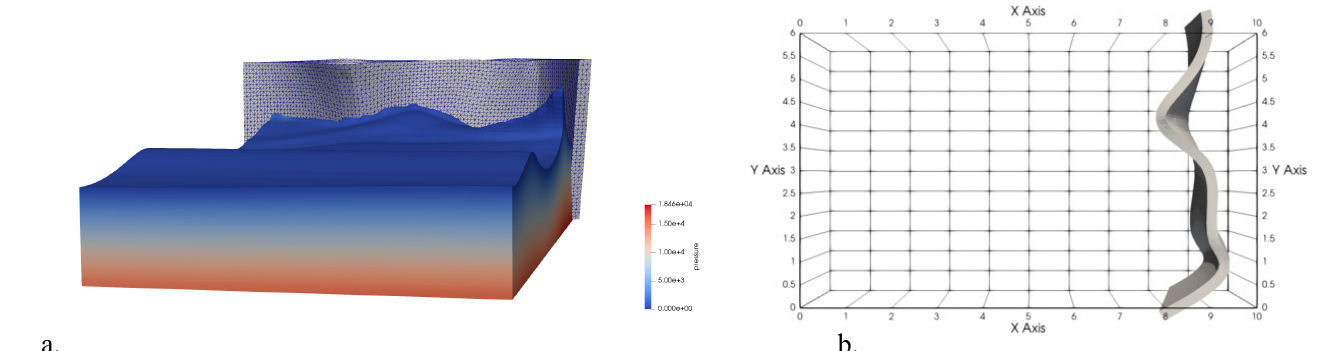
Figure 4. ( a ) Mesh resolution of the wall used in CFD [17], ( b ) Wall’s .stl file imported into REEF3D [25] with designated force box.